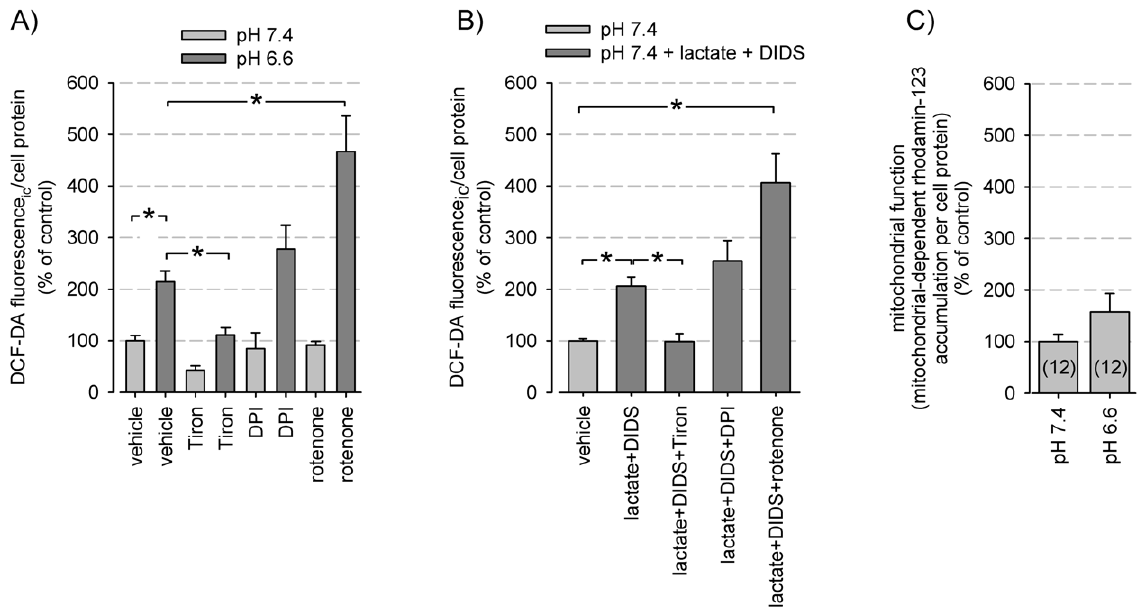
Figure 6. ROS formation induced by extra- or intracellular acidosis. (A) ROS formation during extracellular acidosis with application of the ROS scavengers tiron, DPI or rotenone (N=9-12). (A) ROS formation (measured by DCF-DA fluorescence) during intracellular acidosis (induced by lactate + DIDS; see Fig. 4A) with application of the ROS scavengers tiron, DPI or rotenone (N=3). (C) Relative mitochondrial activity (measured by rhodamine 123 accumulation) at control conditions (pH 7.4) and during extracellular acidosis (pH 6.6); N=12. (*) p ,